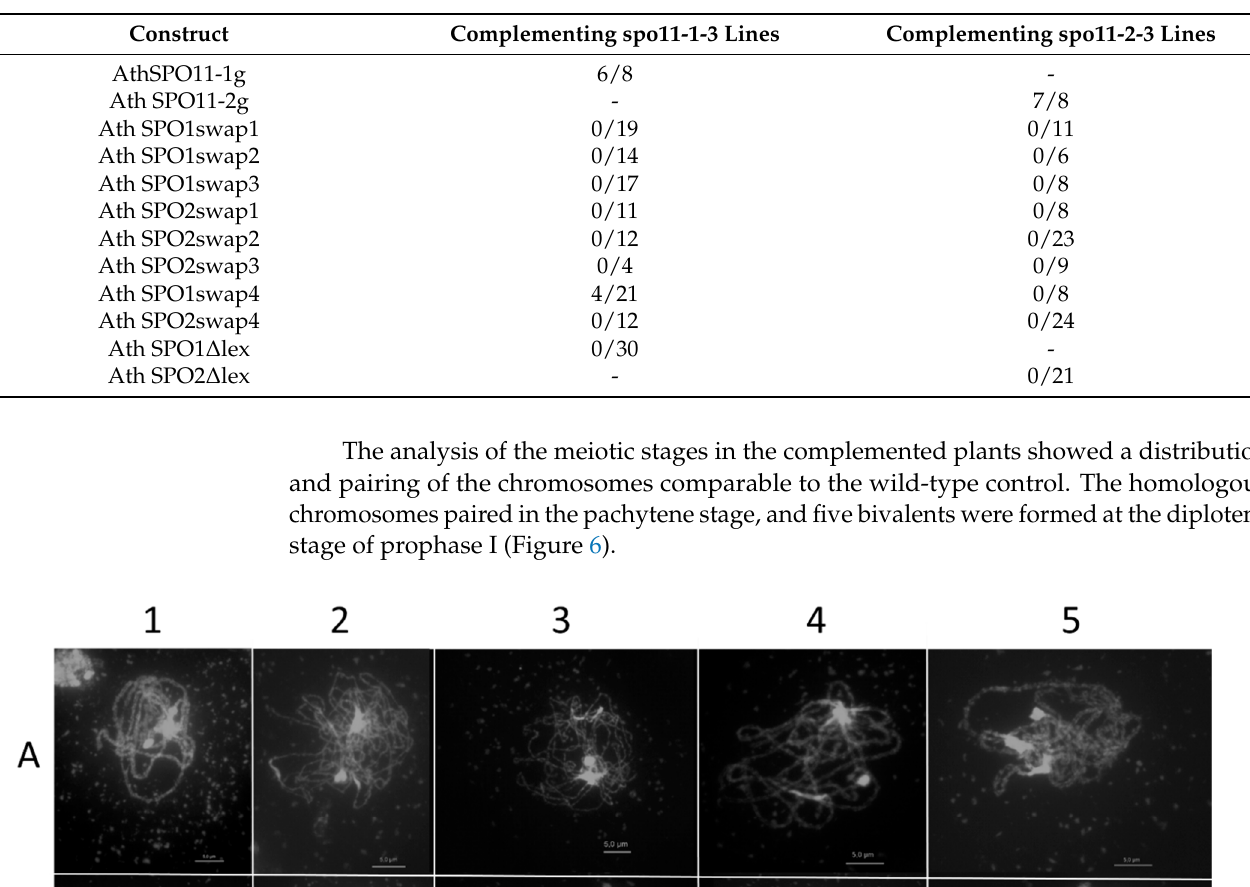
Table 1. Complementation of A. thaliana spo11-1-3 and spo11-2-3 with SPO11-1 or -2 swapped constructs n.d.: not determined.